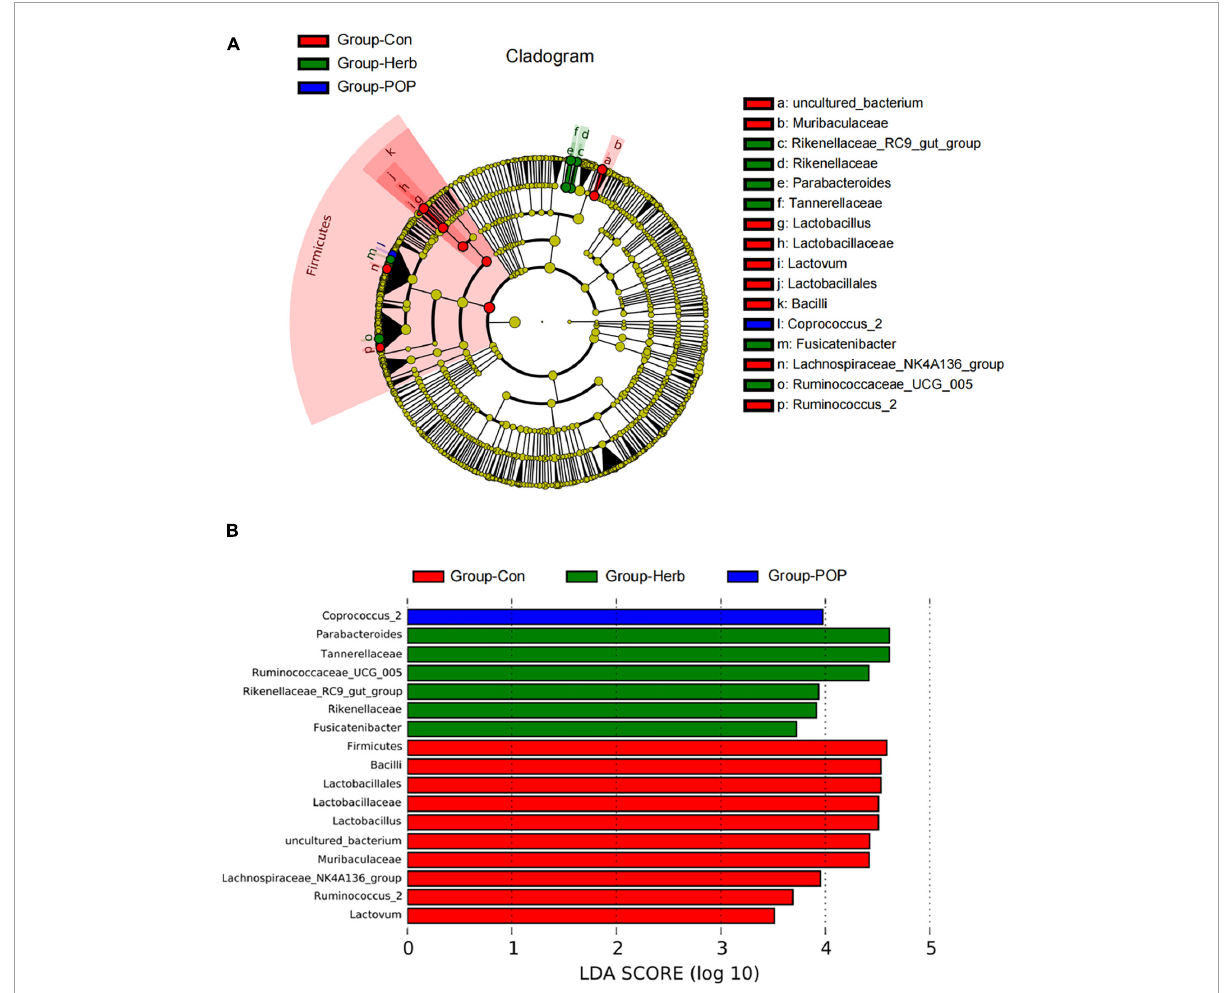
FIGURE5 (A) LEfSe multilevel species hierarchy tree. (B) Microbial populations with an LDA score >